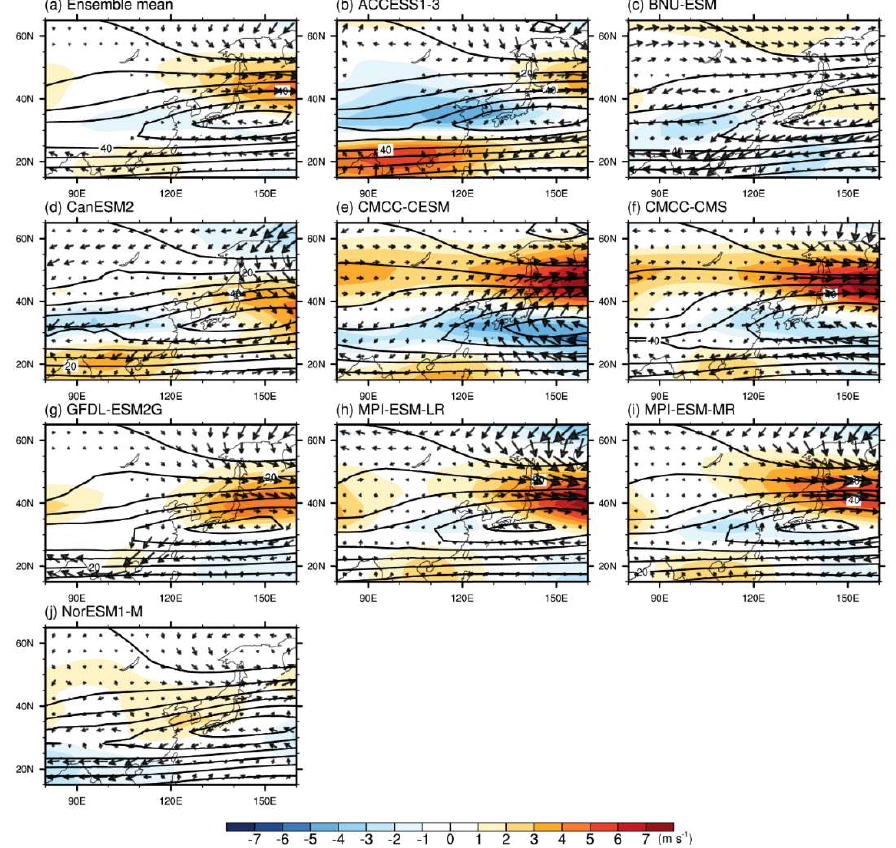
Figure 10. The climatology of zonal wind at 250 hPa (contour: intervals of 10 m s −1 ) for 1975–2005 and the changes in zonal wind at 250 hPa (shading) and wind vector at 850 hPa (m s −1 ) in winter from nine CGCMs and their ensemble mean.